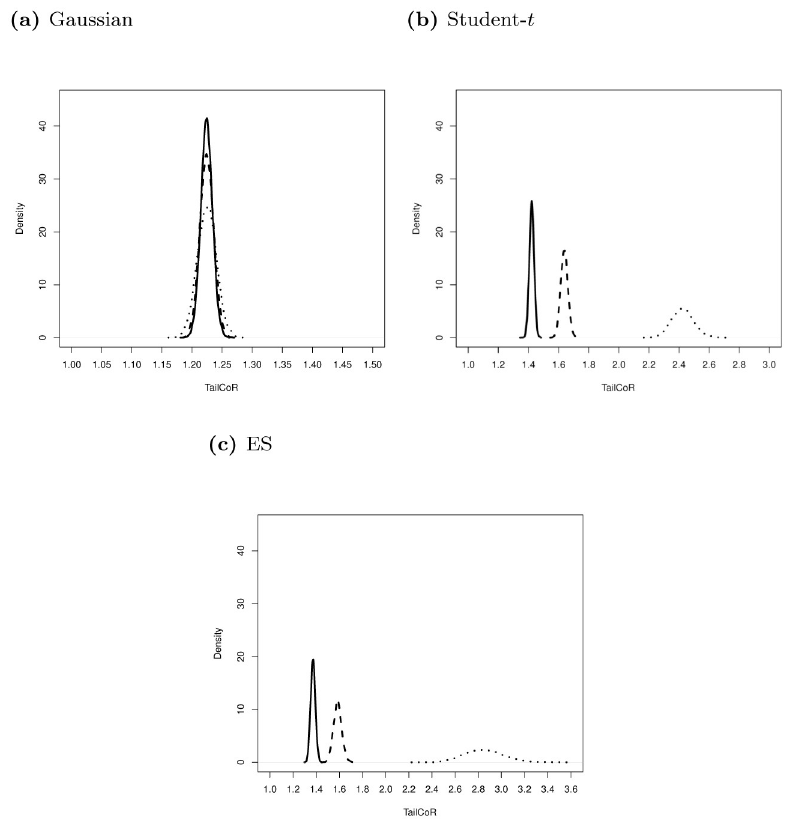
Fig 6. Sensitivity of TailCoR to ξ . Sensitivity of TailCoR to ξ for the Gaussian (panel a), Student- t with α = 2.5 (panel b), and ES with α = 1.5 (panel c) distributions. Each line is the density of the 10000 estimates of TailCoR for different values of ξ : 0.90 (solid line), 0.95 (dashed) and 0.99 (dotted). (a) Gaussian, (b) Student- t , (c)